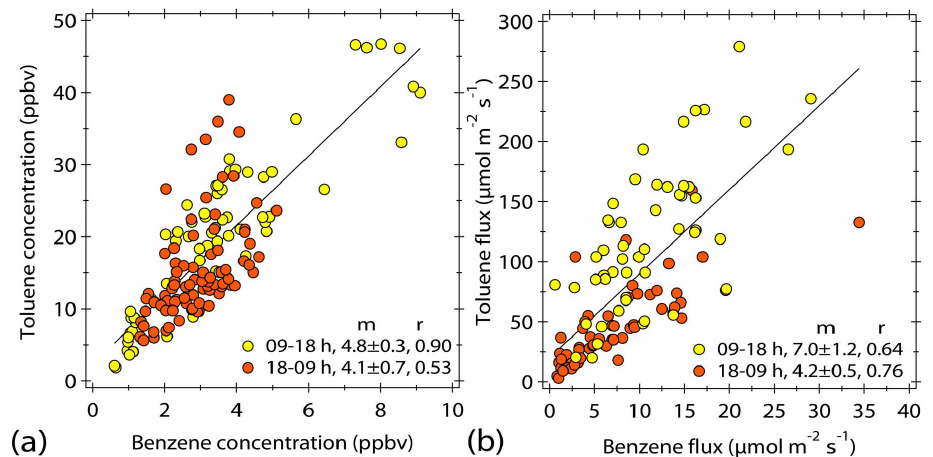
Fig. 6. Correlations between toluene and benzene for ambient concentrations (a) and fluxes (b) . The correlations were calculated for two periods, one including the period of resin application to the sidewalks (9a.m. to 6p.m.), and the second for the remaining time. The black line indicates the regression line for all the data.